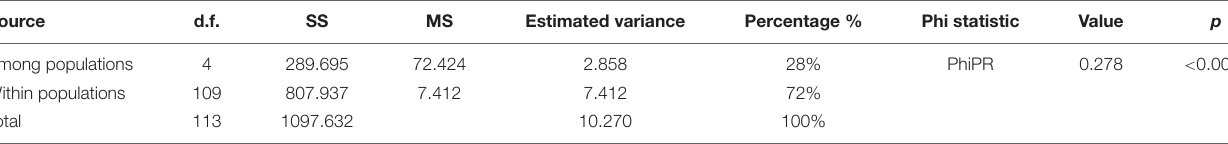
TABLE 5 | Summary of the AMOVA results for five natural populations of K. obovata . Source Among populations Within